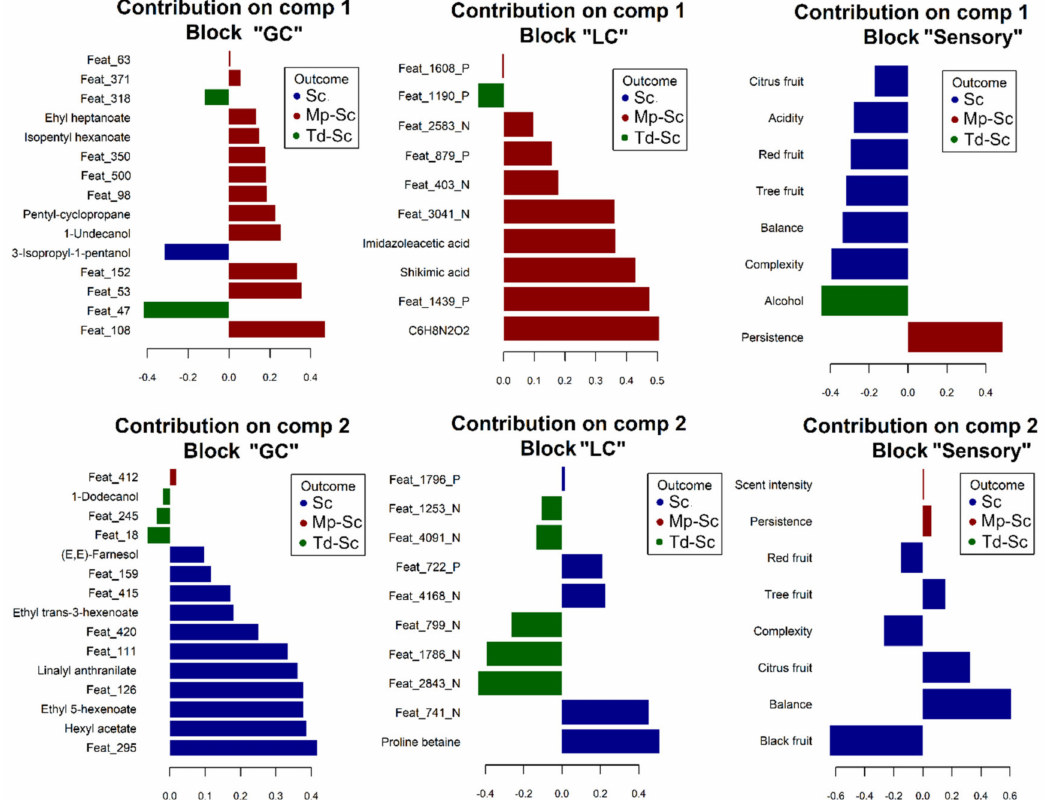
Figure 8. Loading contribution barplot on components 1 and 2 for the different blocks of the sGCC-DA. Colour indicates the class for which the compound has a maximal mean value. Bar length represents the multivariate regression coefficient with either a positive or negative sign for that particular feature of each component, i.e., the importance of each variable in the